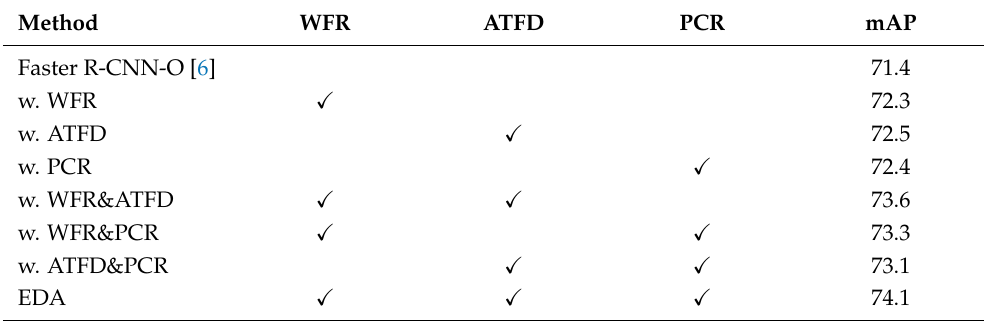
Table 2. Effect of the WFR, ATFD, and PCR